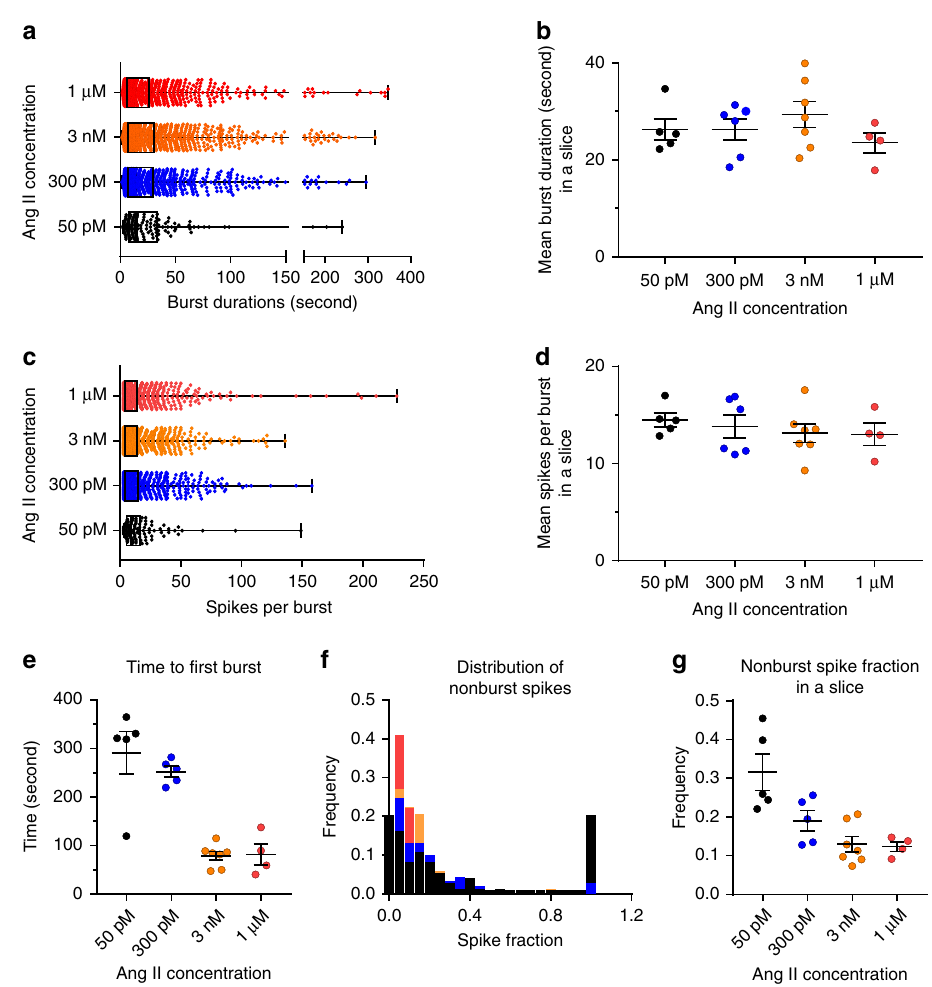
Fig. 4 Burst analysis of Ang II-elicited calcium spikes. Burst duration and number of spikes/burst are consistent across Ang II concentrations. a Box plot of individual burst duration, median value (25 – 75%): 50 pM: 14.6 (8.2 – 14.6); 300 pM: 13.9 (7.3 – 29.3); 3 nM: 13.9 (7.3-30.8); 1 µ M: 11.2 (6.3 – 26.0); b means± SEM [s]: 50pM: 26.3 ± 2.2; 300 pM: 26.3 ± 2.2; 3 nM: 29.4 ± 2.7; 1 µ M: 23.6 ± 2.1; Kruskal – Wallis test: P = 0.4783; c box plot of individual burst spikes, median value (25 – 75%): 50 pM: 6 (4 – 14), 300 pM: 6 (4 – 14), 3 nM: 7 (4 – 14.5), 1 µ M: 9 (5 – 16); d means ± SEM; Kruskal – Wallis test: P =